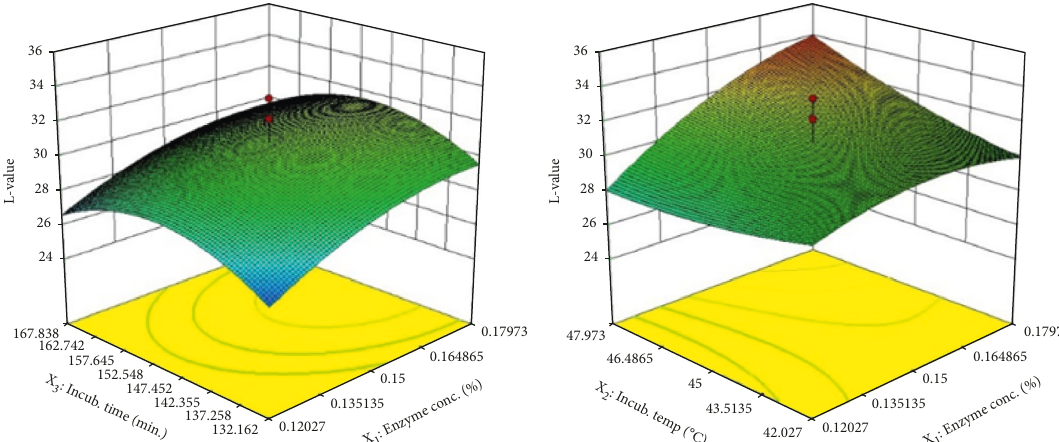
Figure 6: 3D graph plots displaying the linear effect of enzyme concentration ( X